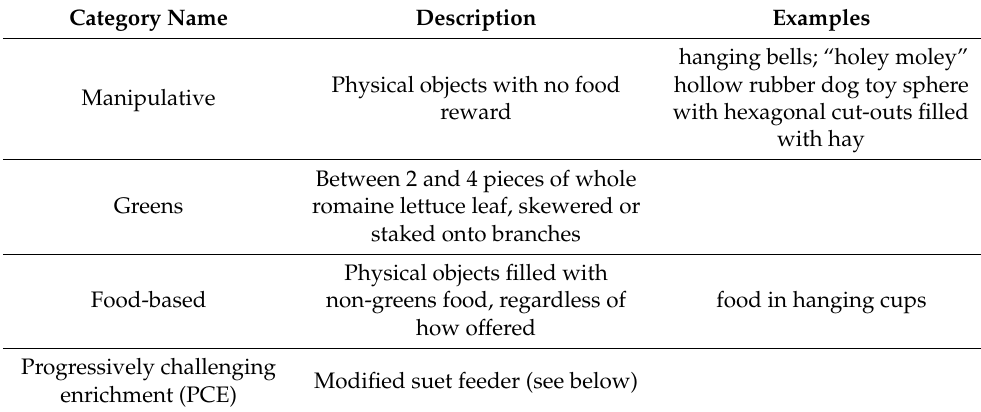
Table 1. Final enrichment category descriptions.